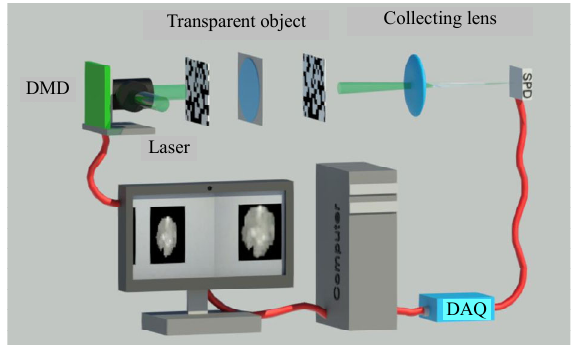
Fig. 3 Schematic of 2-dimensional (2D) transparent object detection.